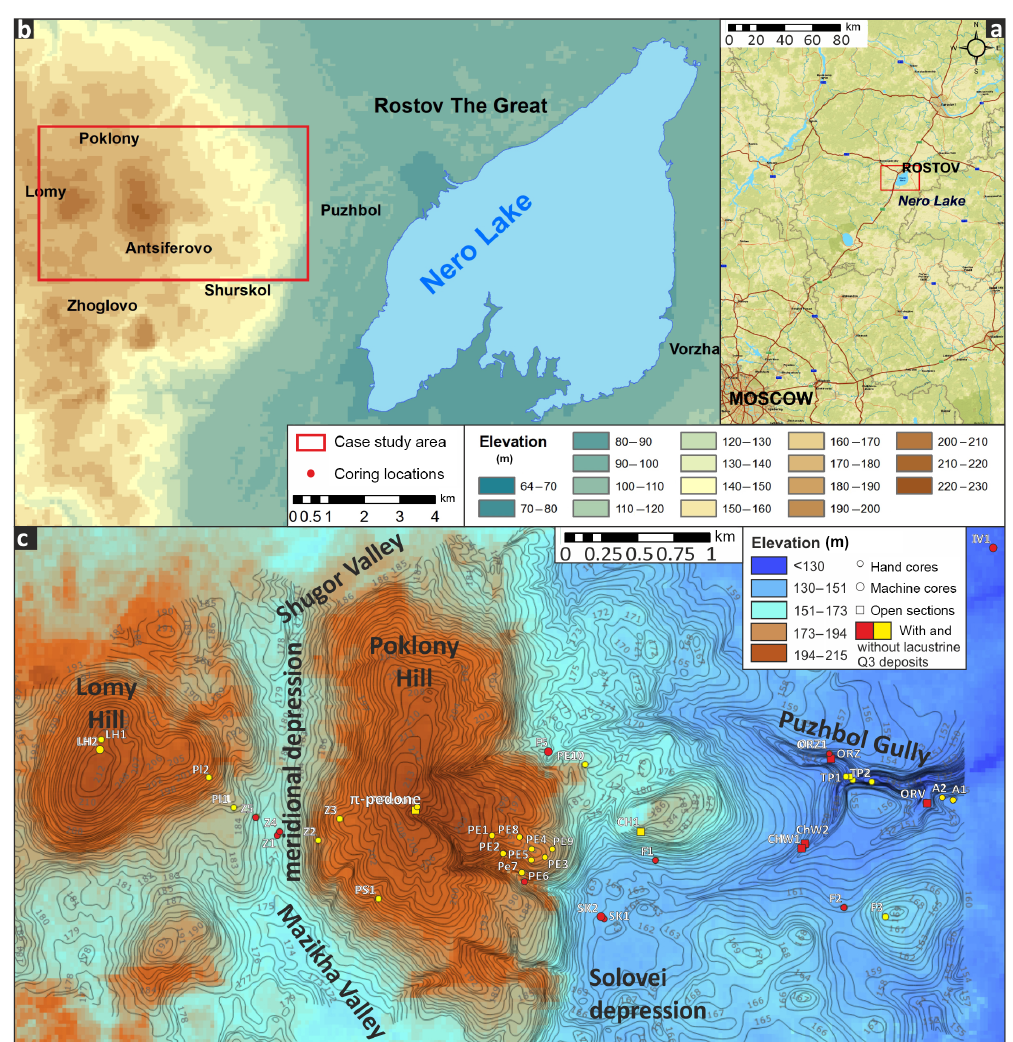
Figure 1. Position of the case study area: (a) at the Central Russian Plain (source: ©Google global topography, infrastructure and settle- ments), and (b) at the eastern Borisoglebsk Upland (source: ©ALOS 3D 30m); (c) its detailed topography based on 1 : 10000 land planning maps (contour interval